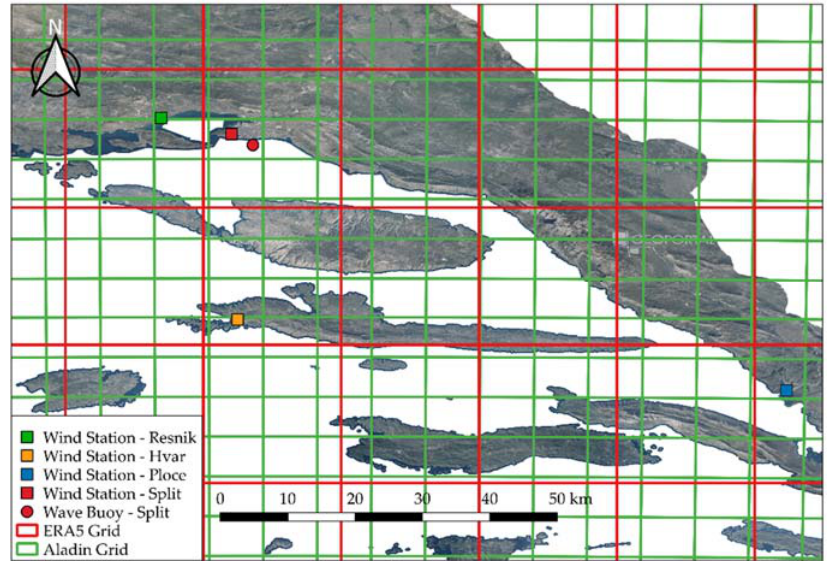
Figure 5. Map of the regional model on southern Croatian coast (mid-latitude Adriatic showing the grid sizes of the ERA5 and ALADIN wind reanalysis models overlaid for size comparison, and four wind stations (rectangles) and one wave station (circle) described in detail in Section 2.3; the map is shown in the coordinate reference system EPSG: 4326—WGS 84.